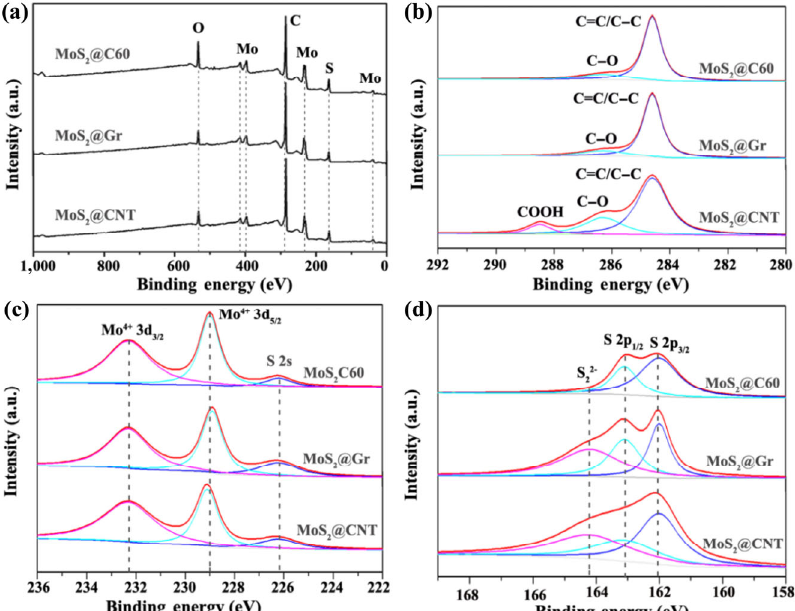
Fig. 3 XPS spectra of MoS 2 @CNT, MoS 2 @Gr, and MoS 2 @C60 nanocomposites. (a) Survey spectra, high resolution XPS spectra of (b) C 1s, (c) Mo 3d, and (d) S